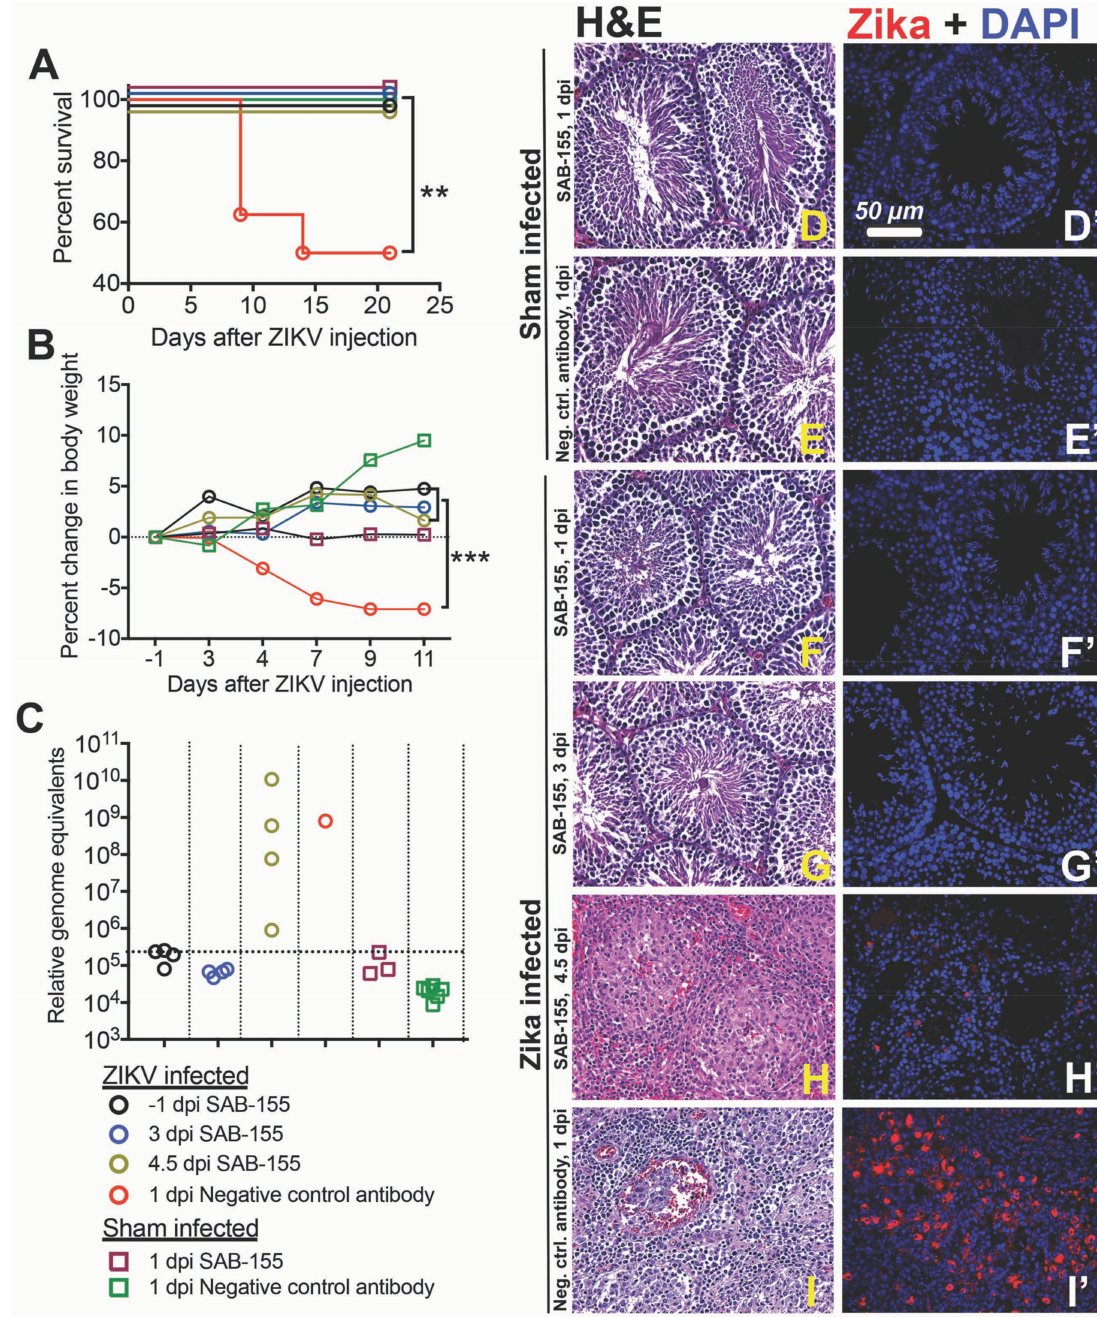
Figure 3. Identifying effective day of treatment with single dose of 100 mg/kg of SAB-155. Equal numbers of male ( n = 4) and female ( n = 4) STAT2 KO hamsters infected with ZIKV PRVABC69 and treated i.p. with SAB-155 at different pre-and post-infection days either at − 1, 3 or 4.5 dpi. Sham infected controls had 2 males and 2 female hamsters. ( A ) survival, (since five groups had 100% survival, data has been adjusted to display all groups); ( B ) temporal change in body weight relative to the day of virus challenge; ( C ) RT-PCR analysis of ZIKV RNA in testes of hamsters that survived up to at 21 dpi compared with sham infection; ( D – I ), Hematoxylin and eosin staining of cross section of testis tissue from ZIKV infected and SAB-155 treated STAT2 KO hamsters. Arrows on the H pointing to the infiltrated cells. ( D’ – I’ ) immunohistochemical staining of ZIKV antigen (red color) in cross-section of testes tissue and DAPI (blue color) stained nuclei. **, p < 0.05; ***, p < 0.001; compared 1 dpi negative control antibody 100 mg/kg treated group with other groups, using one-way ANOVA test. Dashed lines indicate limit of detection in Figure